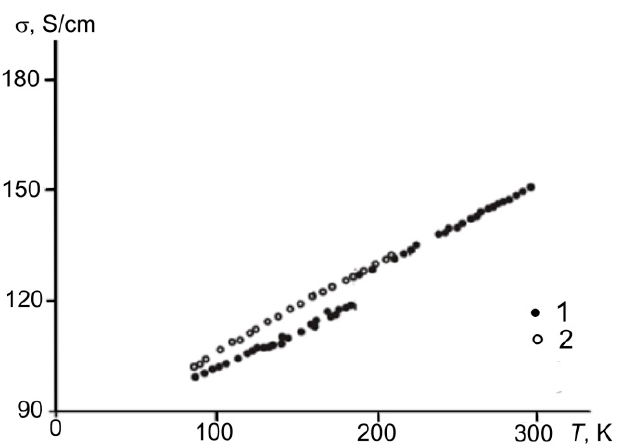
Figure 9. Temperature dependence of the electrical conductivity of shungite carbon upon cooling from 300 K (1) and heating from 77 K (2) (adapted from